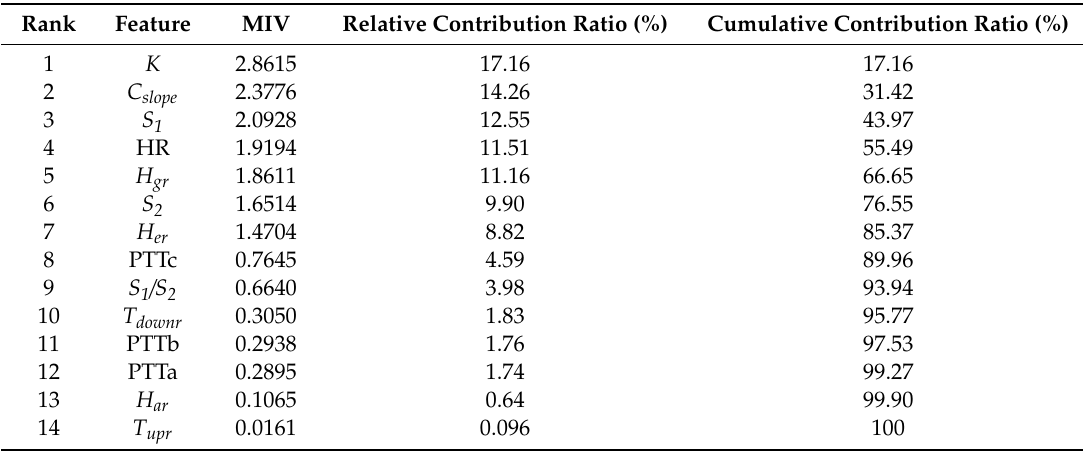
Table 2. Mean impact value (MIV) ranking of features regarding the SBP estimation model using genetic algorithm optimized support vector regression (GA-SVR).